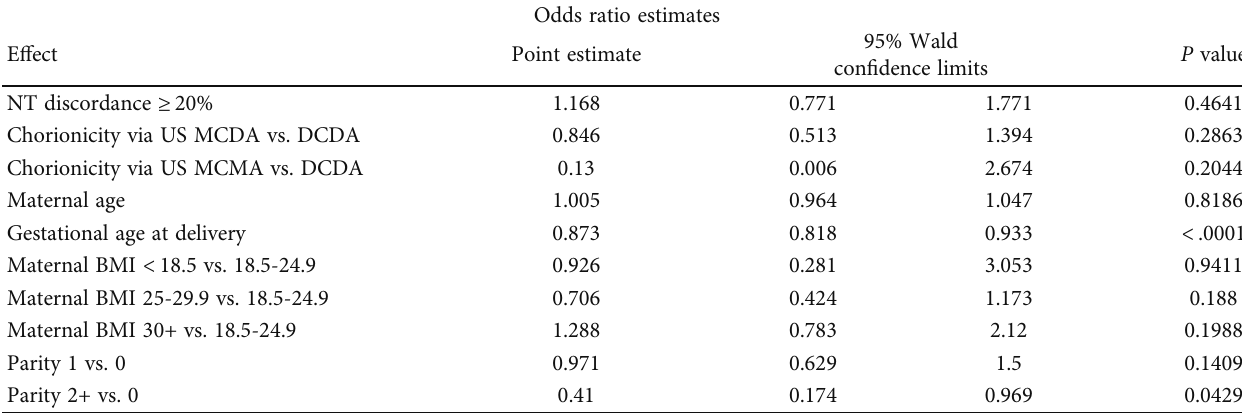
Table 3: Multivariate probability modeling the e ff ect of NT discordance ≥ 20% on birth weight discordance.